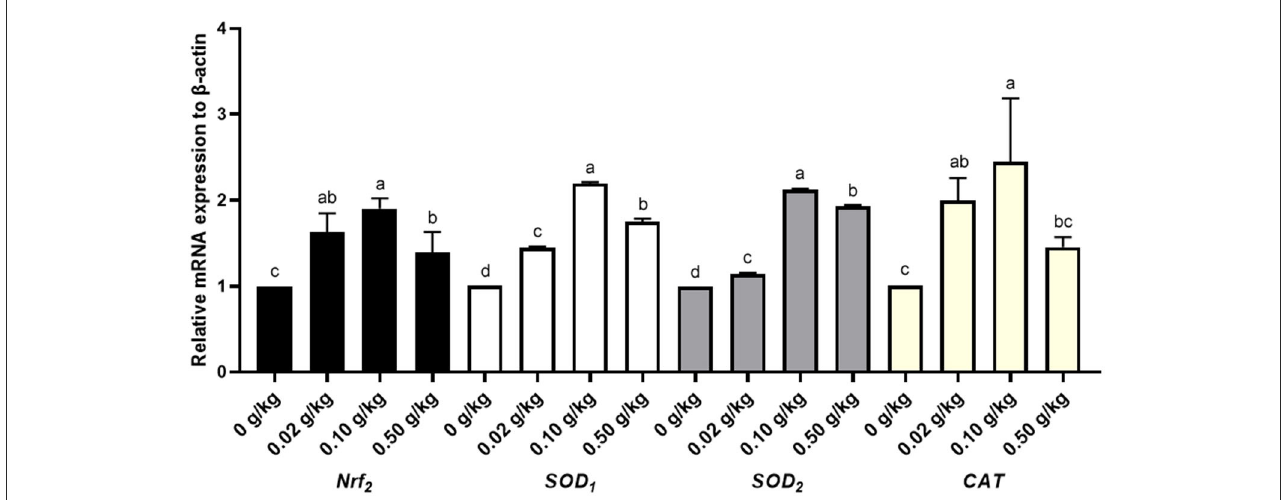
FIGURE1 Hepatic antioxidative gene expression profiles in 48-day-old broilers. Nrf 2 , nuclear factor E2-related factor 2; SOD 1 , superoxide dismutase 1; SOD 2 , superoxide dismutase 2; CAT , catalase. In the figure, antioxidative gene expression profiles of Nrf 2 , SOD 1 , SOD 2 , and CAT , in the livers of 48-day-old broilers were detected by qRT-PCR. The values with different lowercase superscripts indicate significant differences ( P < 0.05), while values with the same lowercase superscripts indicate no significant differences ( P >